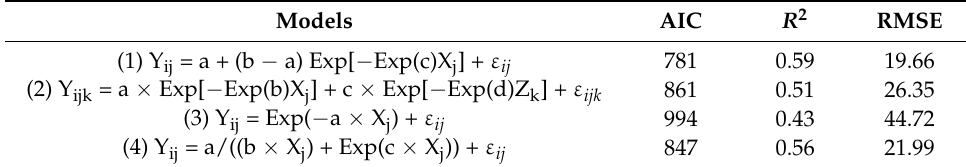
Table 4. Fit statistics for the tested yield loss models, using Akaike’s information criteria (AIC), Coefficient of determination ( R 2 ) and root mean square error